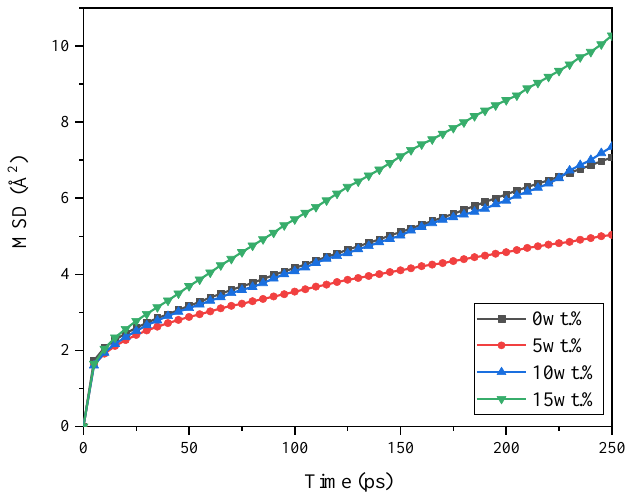
Figure 7. The comparatively MSD of pure VNR and CNT/VNR composites.